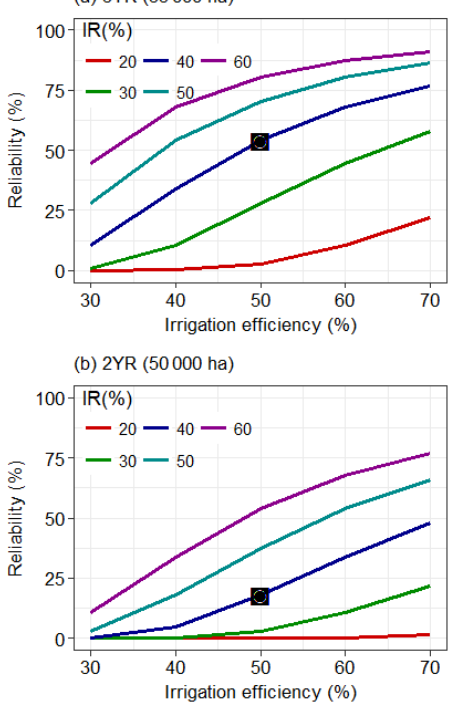
Figure 7. Mean reliability vs. irrigation efficiency (IE) at different levels of intake ratio (IR) of the 3- and 2-year rotation systems (the black square indicates typical values of IR and IE).